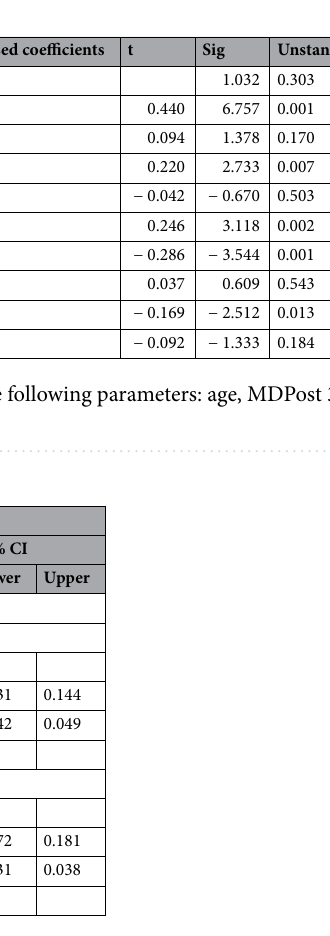
Table 4. Comparison of the RCA index value in the Control group and the CSDH